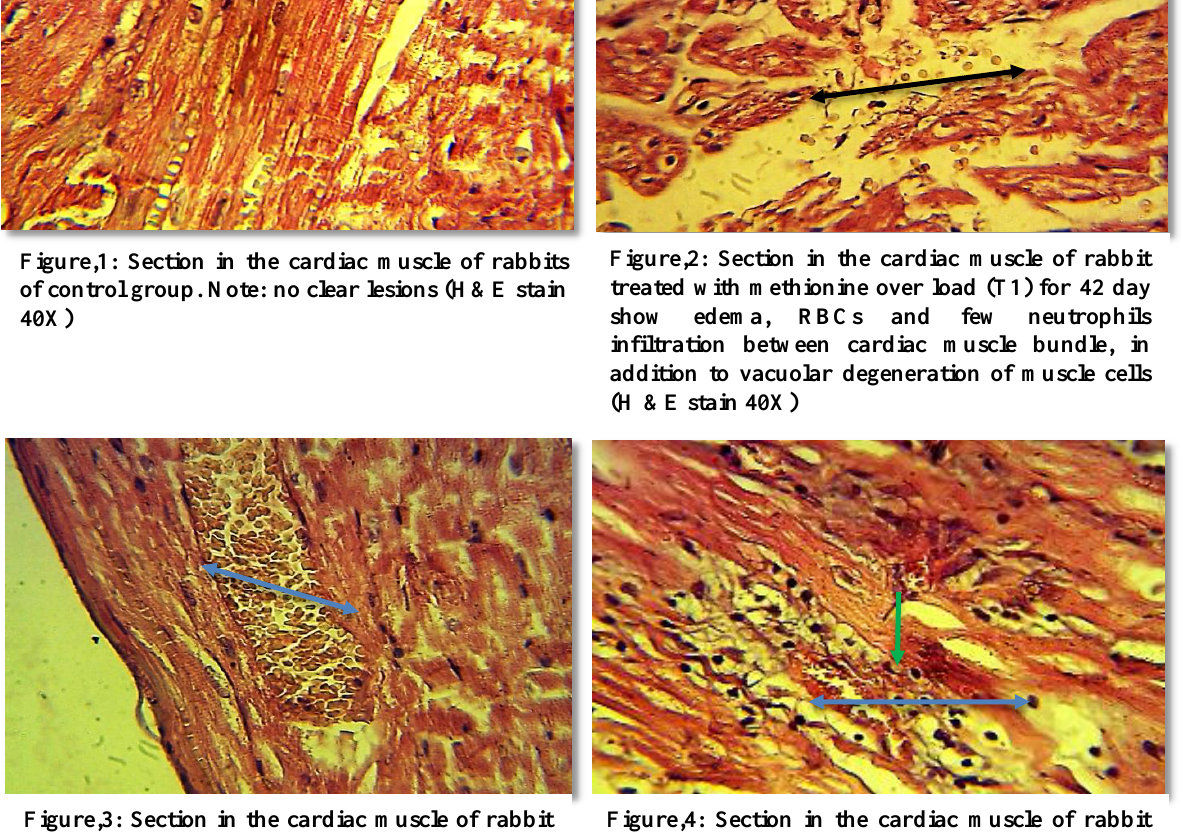
Figure,4: Section in the cardiac muscle of rabbit treated with methionine over load for 42 days (group T1). Note: inflammatory cells infiltration particularly neutrophils and macrophages and